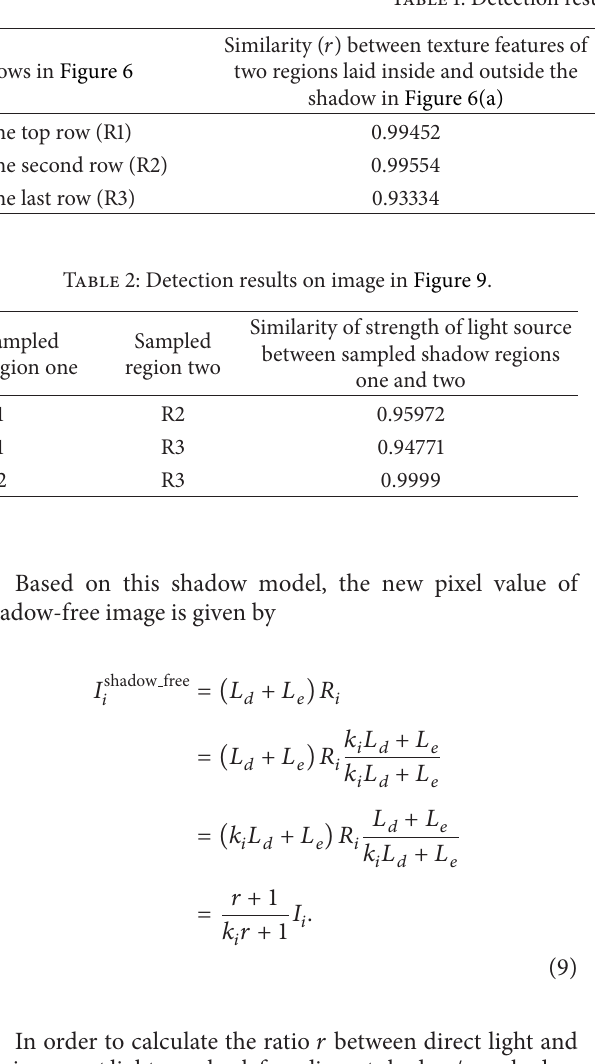
Table 1: Detection result on image in Figure 6.